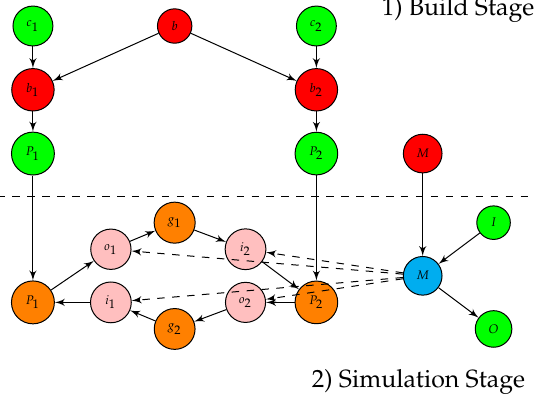
Figure 2. Simple example of a co-simulation process graph. The build stage is a DAG, while the simulation graph contains